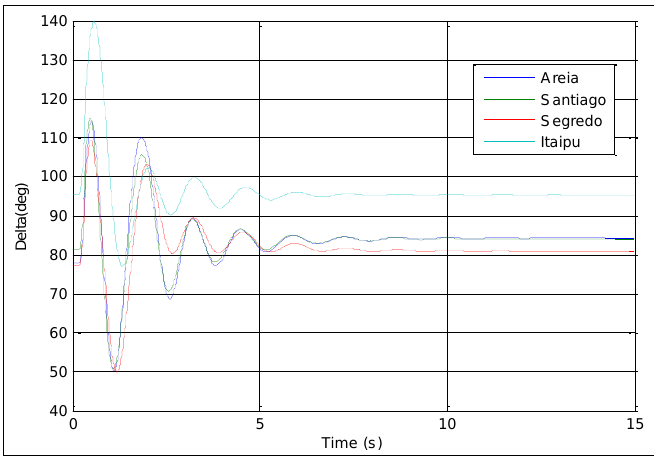
Figure 7: Generators rotor angle -